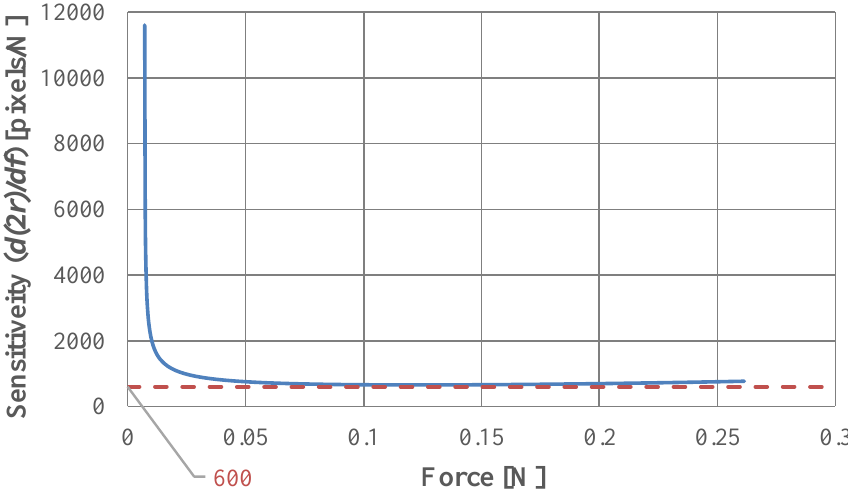
Figure 11. Relationship between sensitivity d (2 r )/ df and applied force.